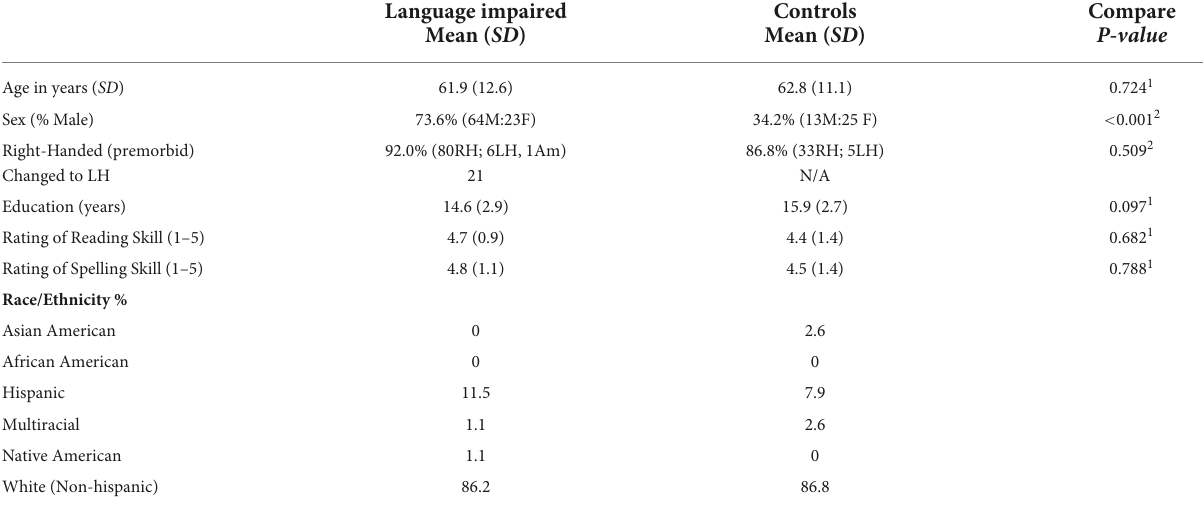
TABLE 1 Demographic characteristics of those with acquired language impairment ( n = 87) and neurotypical controls ( n =